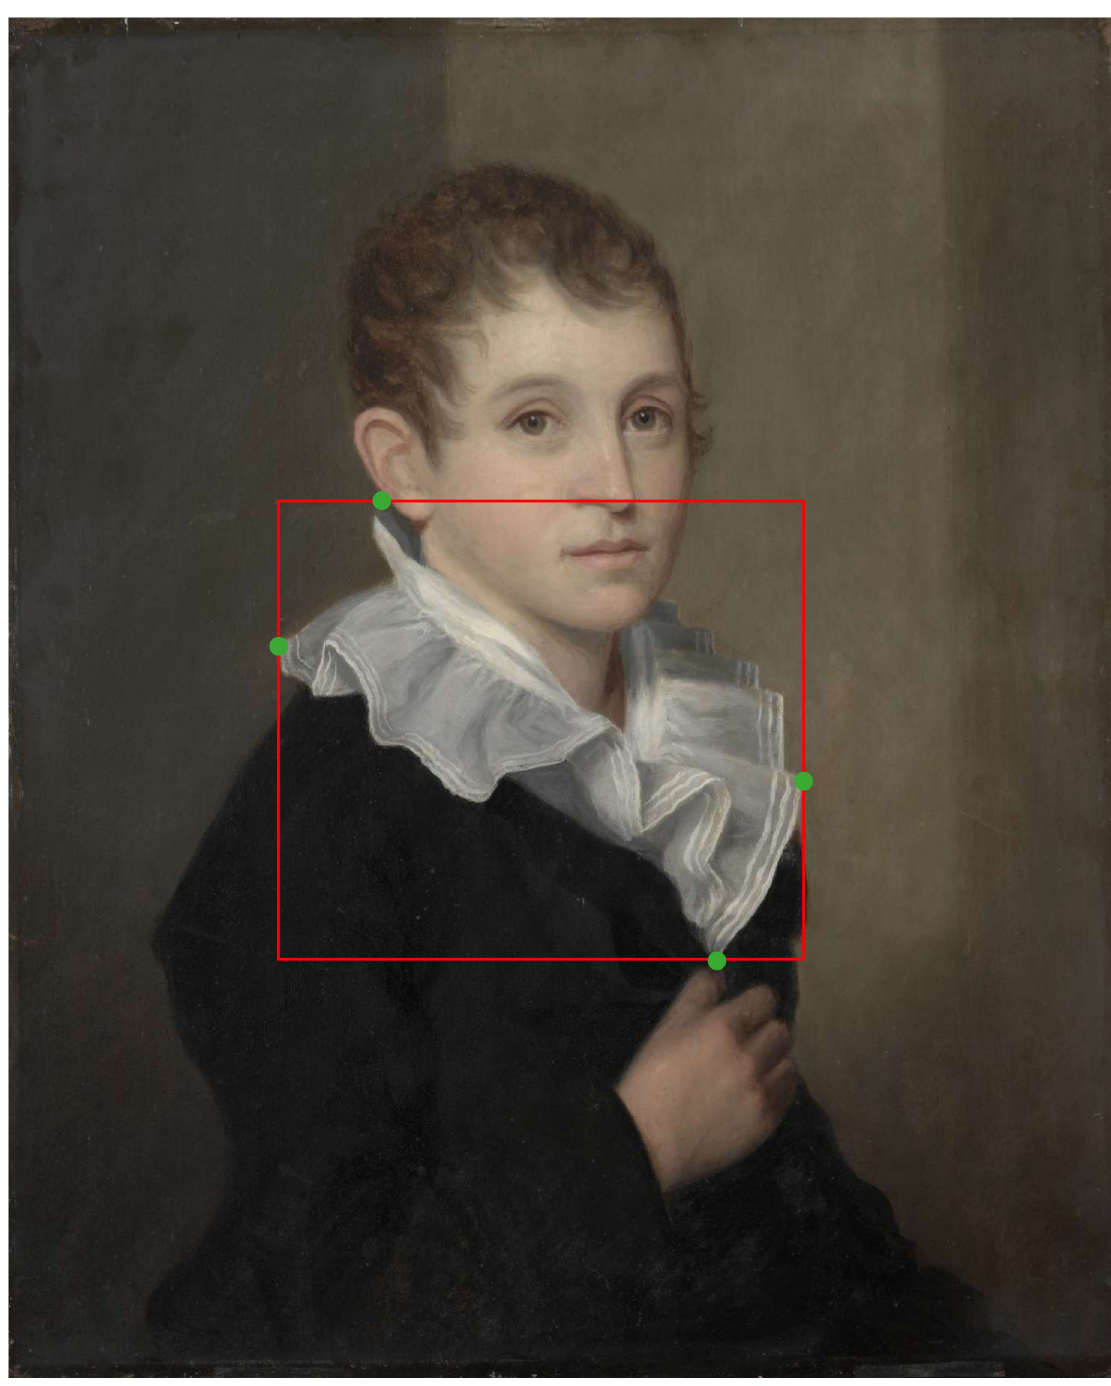
Fig 2. An example of four extreme clicks (marked in green) made by a user on a piece of fabric. These points correspond to the most left, most right, highest and lowest points on the annotated item. The red-line displays the resulting bounding box. Samuel Barber Clark ,